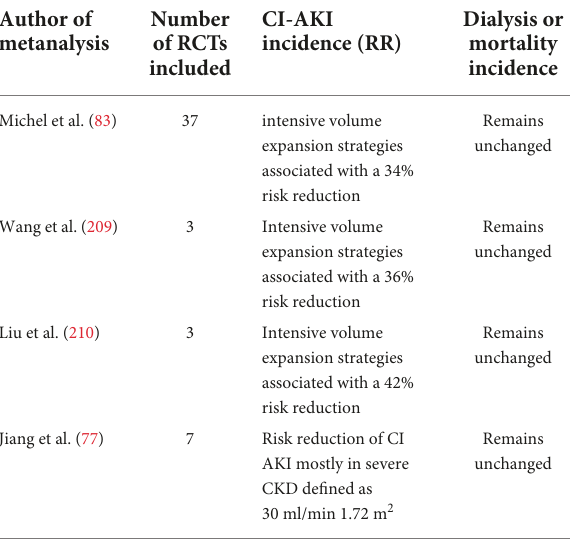
TABLE 6 Comparing meta-analysis of intravascular volume expansion as a prevention method for contrast associated acute kidney